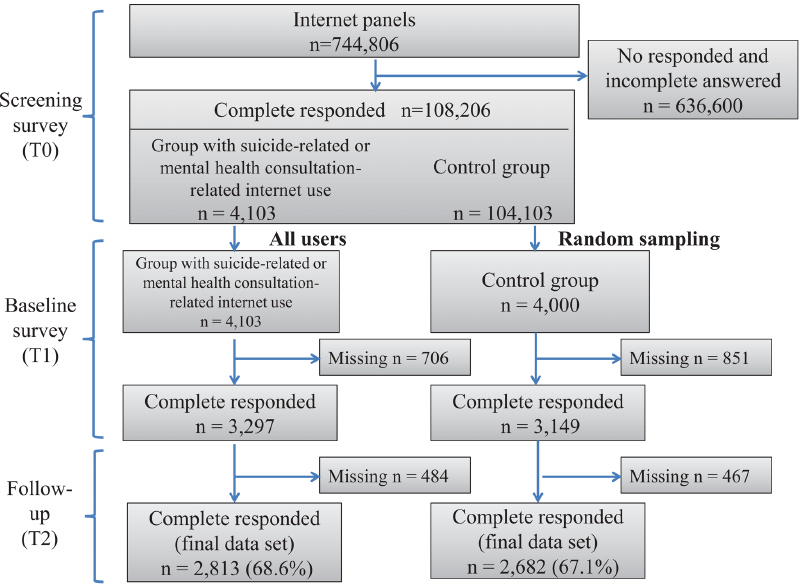
Figure 1. Flow chart of the study. This shows the sampling process of this study.